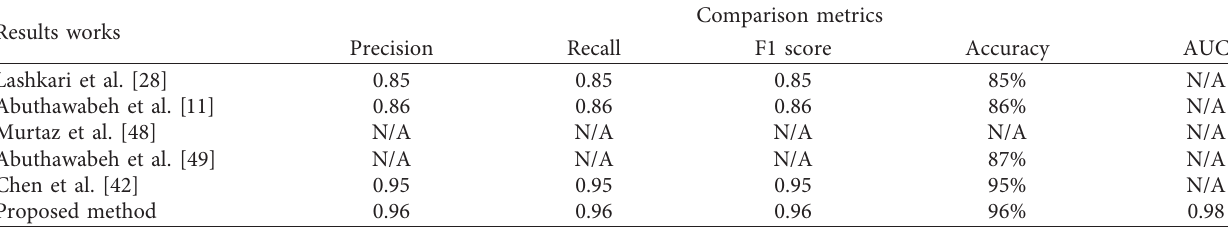
Table 13: Result of performance evaluation and comparison metrics in binary classification.